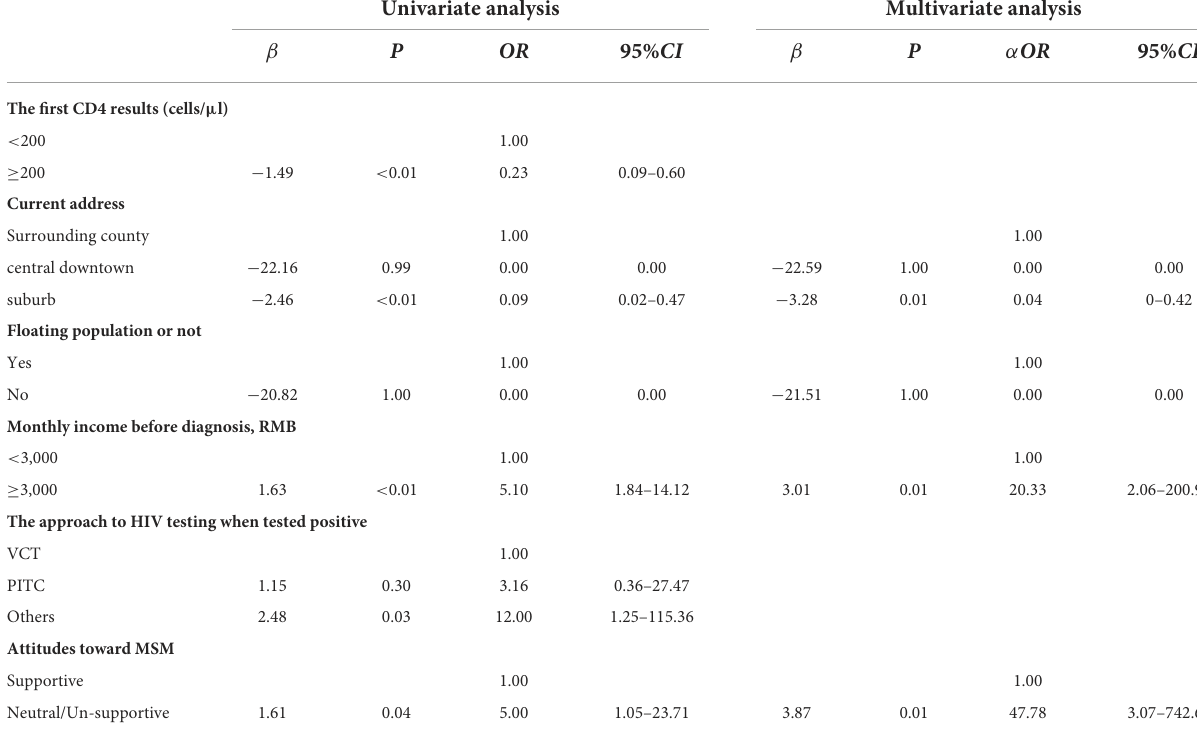
TABLE 4 Factors correlated with non-disclosure of same-sex behaviors even after medical care. Univariate analysis Multivariate